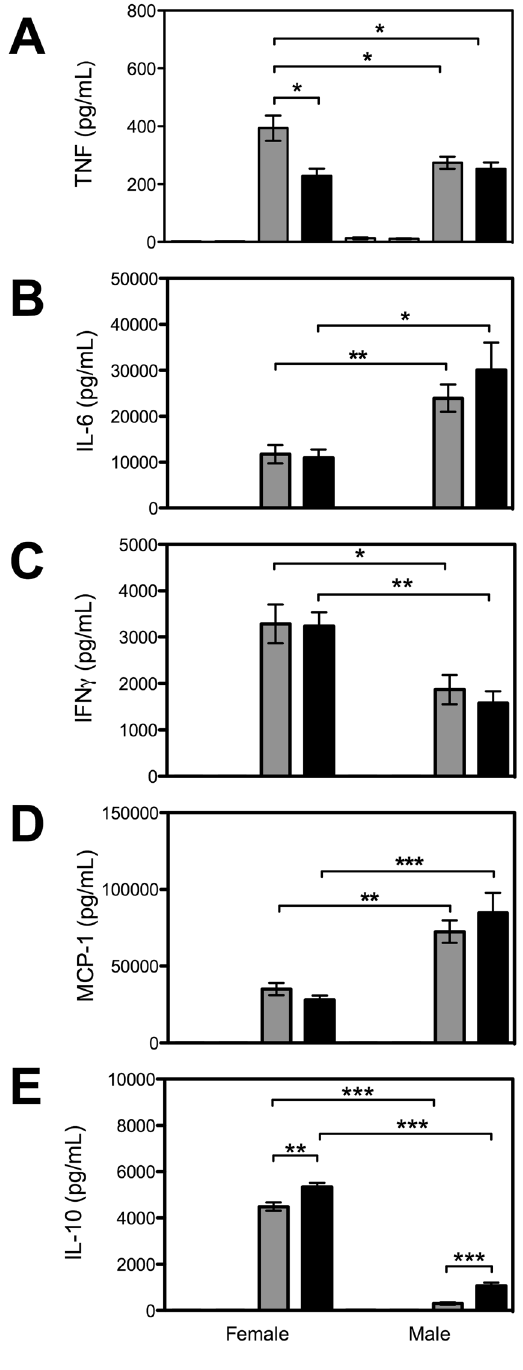
Figure 5. Plasma cytokine levels in mice six h following E. coli challenge. Saline WT = white bar; Saline β 2GPI − / − = light grey bar; E. coli WT = dark grey bar; E. coli β 2GPI − / − = black bar. Female WT n = 8 saline and n = 10 E. coli; Female β 2GPI − / − n = 7 saline and n = 10 E. coli; Male WT n = 5 saline and n = 10 E. coli , Male β 2GPI − / − n = 5 saline and n = 10 E. coli . ( A ). TNF ( B ). IL-6 ( C ). IFN γ ( D ). MCP-1 ( E ).